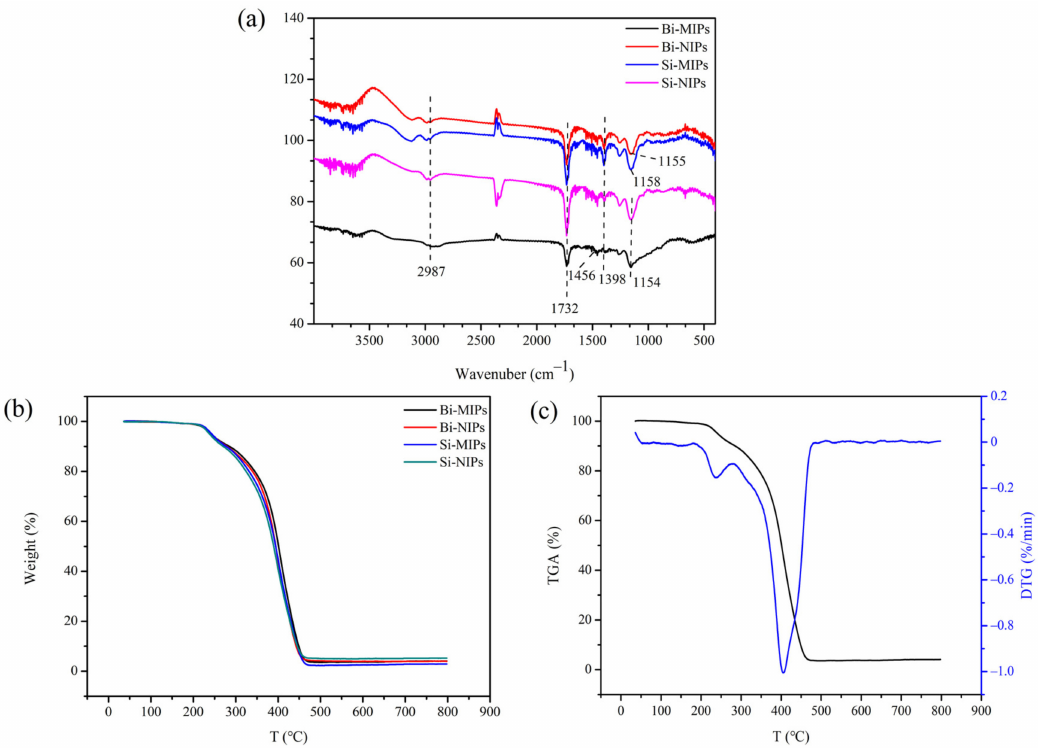
Figure 3. ( a ) FI-IR images of the Bi-MIPs, Bi-NIPs, Si-MIPs and Si-NIPs; ( b ) TGA images of the Bi-MIPs, Bi-NIPs, Si-MIPs and Si-NIPs; ( c ) TGA and DTG images of the